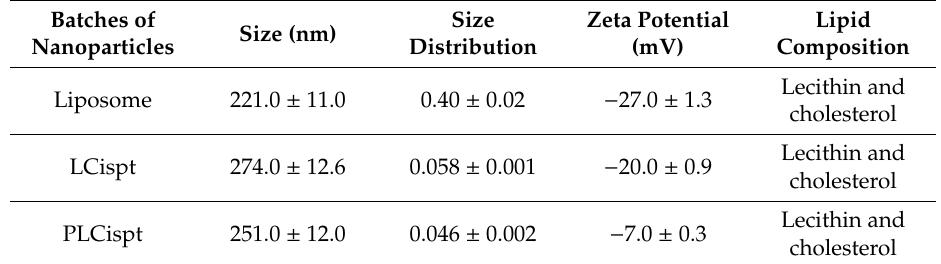
Table 1. The size, size distribution, and zeta potential of liposome, Cispt-loaded liposome (LCispt), and PEGylated liposome